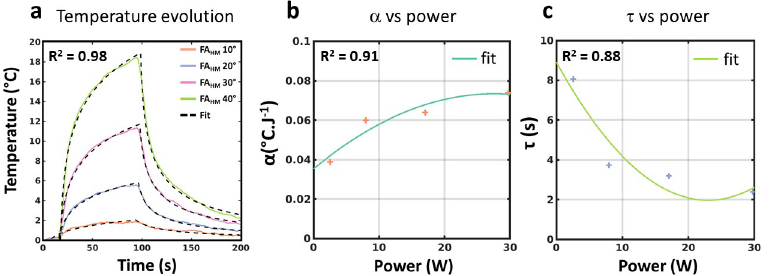
Fig 7. Temperature data for 4 different FA HM . (a) experimental and fitted curves for FA MH of 10˚, 20˚, 30˚ and 40˚. (b) Plot of α as a function of power. (c) Plot of τ as a function of power. In (b) and (c), solid lines represent the result of the polynomial fit with the resulting equations: α = − 4.996 P 2 + 2.758x10 -2 P +3.531x10 -2 and τ = 1.316x10 -2 P 2 -6.049x10 -1 P +